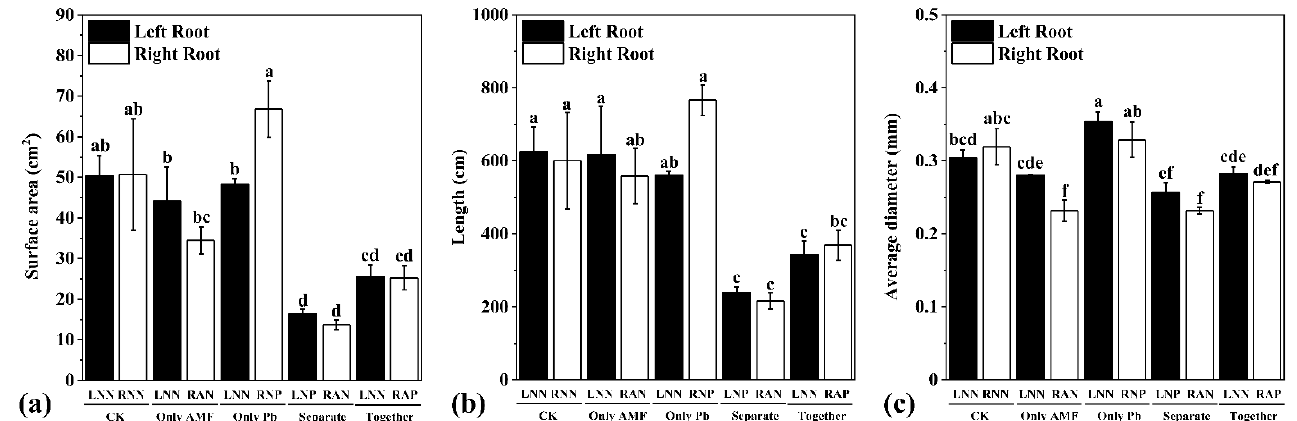
Figure 3. The root surface area ( a ), length ( b ), and average diameter ( c ) of M. truncatula in different treatments. The data are the means ± standard error ( n = 3). Different letters above the columns indicate a significant difference among the means by LSD test ( p < 0.05), respectively. The abbreviations are consistent with Figure 1.